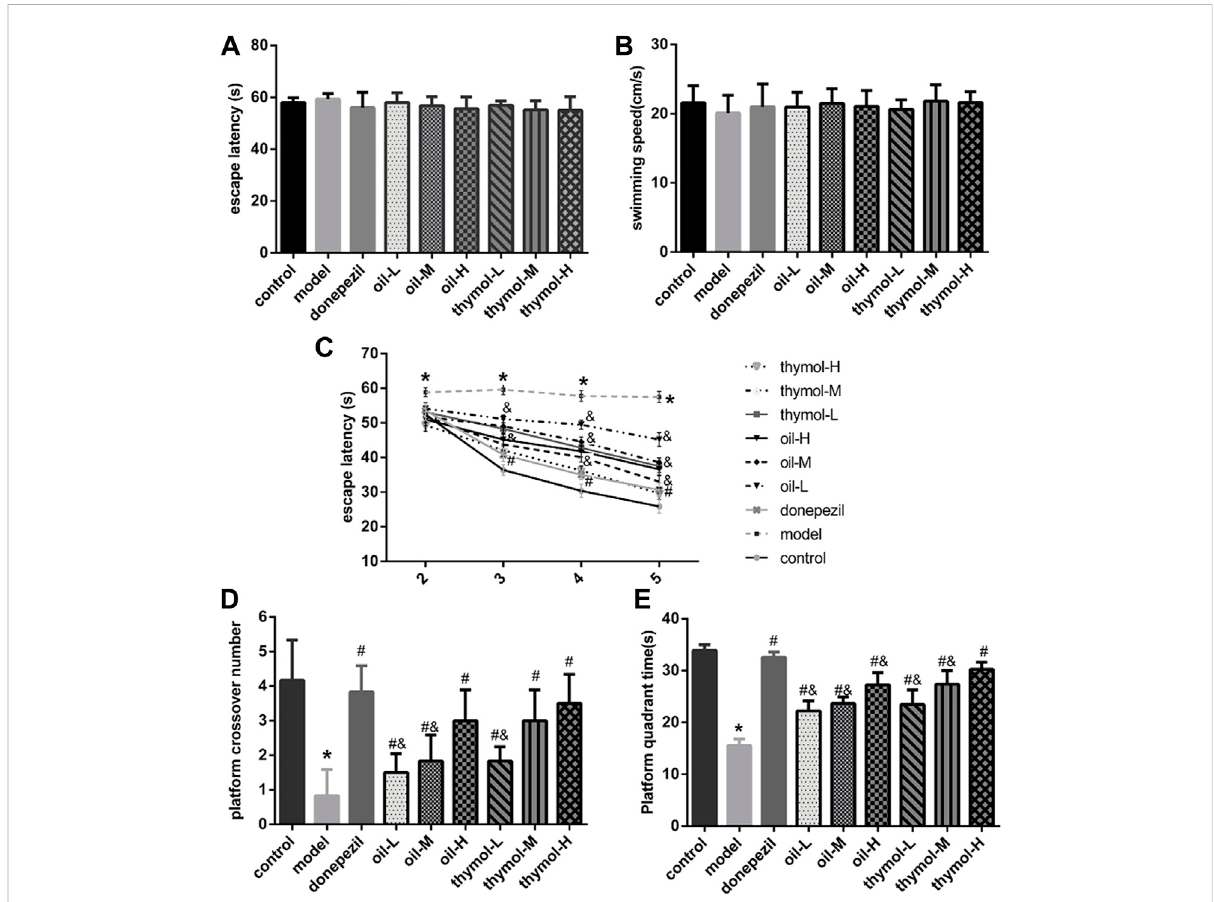
FIGURE 1 Comparison of water maze test results of mice in each group. (A) Comparison of escape latency of mice in plateau stage; (B) Comparison of averageswimmingspeedofmice intheplateaustage; (C) Comparativeanalysisofescapelatency ofmice inhidingplateaustage; (D) Comparison of thenumberoftimesofmicecrossingtheplatforminnon-platformstage; (E) Comparisonofplatformquadrantactivitytimebetweengroupsinnon- platform phase; Compared with control group * p < 0.05; Compared with model group # p < 0.05; compared with donepezil group & p < 0.05 n = 10.